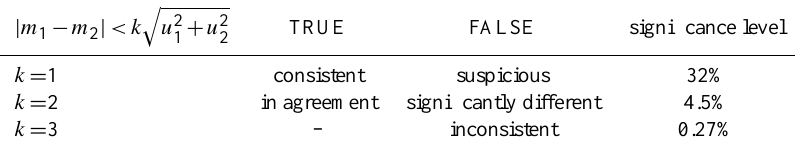
Table 1. Terminology for checking a pair of independent measurements of the same quantity for